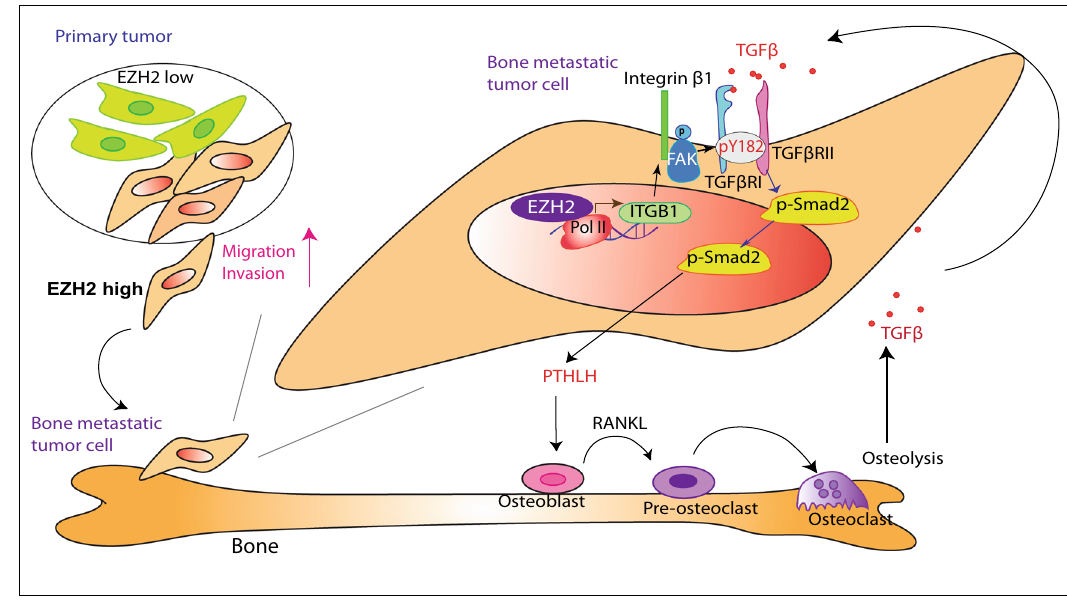
Fig. 7 A model of EZH2 ’ s interaction with TGF β signaling in enhancing breast cancer bone metastasis. High EZH2-expressing cells have strong ability to invade and metastasize from the primary tumor to the bone. In bone-metastatic tumor cells, EZH2 functions as a transcription co-factor to increase ITGB1 transcription. Integrin β 1 activates FAK and induces phosphorylation at Y397 of FAK, which phosphorylates TGF β RI at Y182. pY182-TGF β RI increases binding with TGF β RII, thereby activating pS465/467-Smad2, PTHLH expression, and the vicious cycle of breast cancer bone